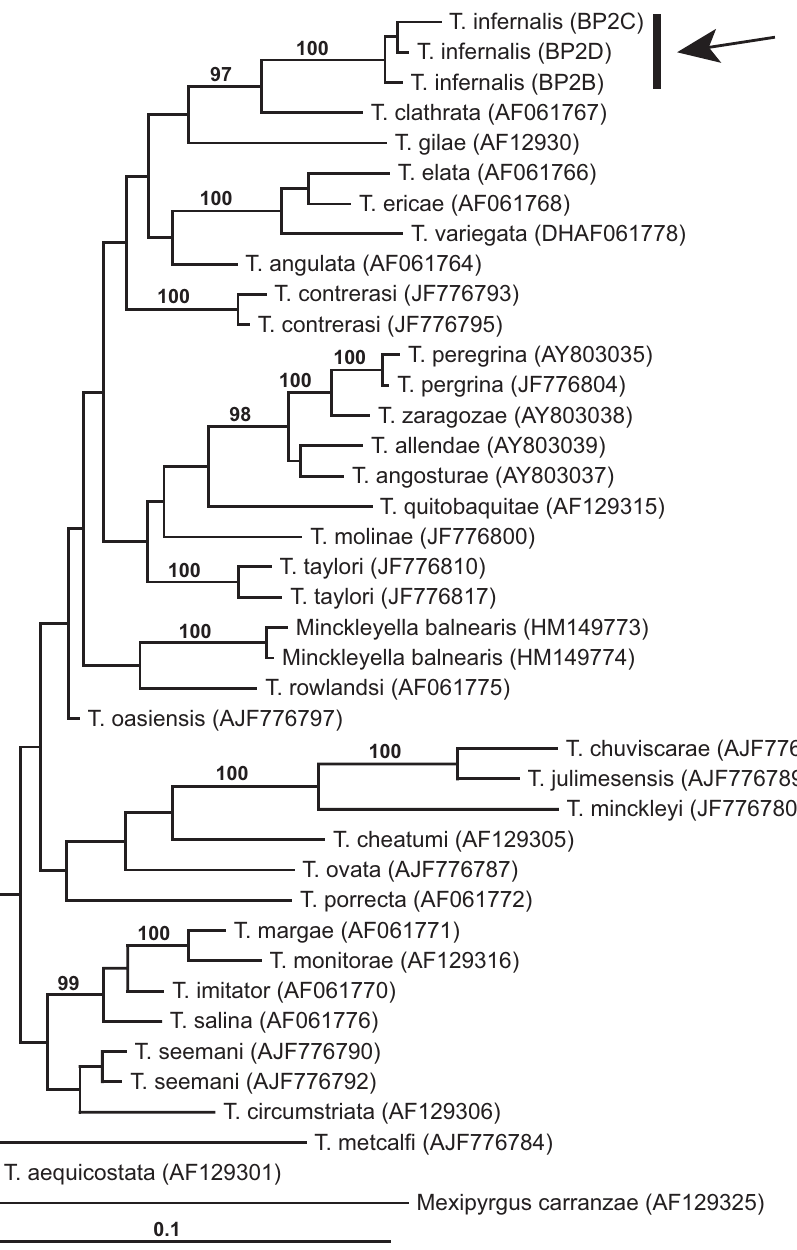
Figure 3. Bayesian tree based on COI data delineating the phylogenetic relationships of the Blue Point Spring Tryonia (lineage highlighted by arrow). Posterior probabilities for nodes are indicated when >95%. GenBank accession numbers for haplotypes are given in